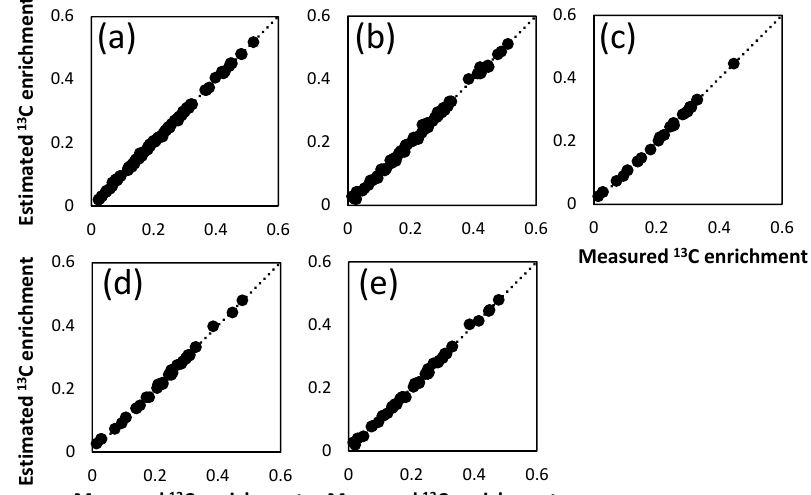
Figure 2. Comparison of measured and estimated 13 C enrichment of amino acids. The X axis and Y axis indicate measured and estimated 13 C enrichment, respectively, of the ( a ) PAAs_fullset; ( b ) FAAs_fullset; ( c ) FAAs_Glu+Asp; ( d ) FAAs_Glu+Asp+Ala; and ( e )